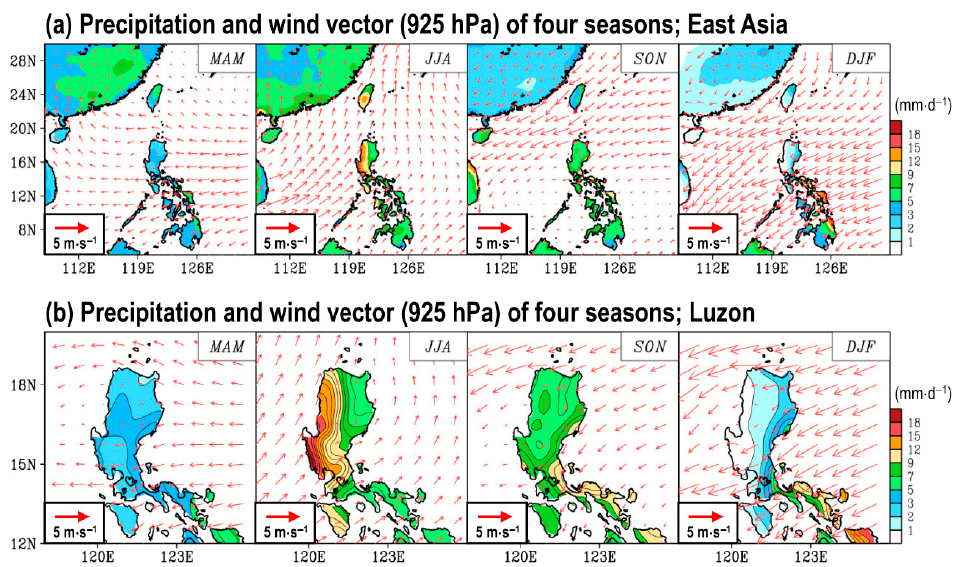
Figure 2. Spatial distribution for the precipitation and wind vector (925 hPa) during four seasons that was averaged from 2003–2015 over two selected domains: ( a ) East Asia (108°E–133°E, 5°N– 30°N); and ( b ) Luzon (118°E–126°E, 12°N–20°N). Precipitation was extracted from the APHRODITE (hereinafter APHRO), while the wind vector was extracted from the ERA5 reanalysis. MAM, JJA, SON, and DJF denote March to May (spring), June to August (summer), September to November (autumn), and December to February (winter), respectively.